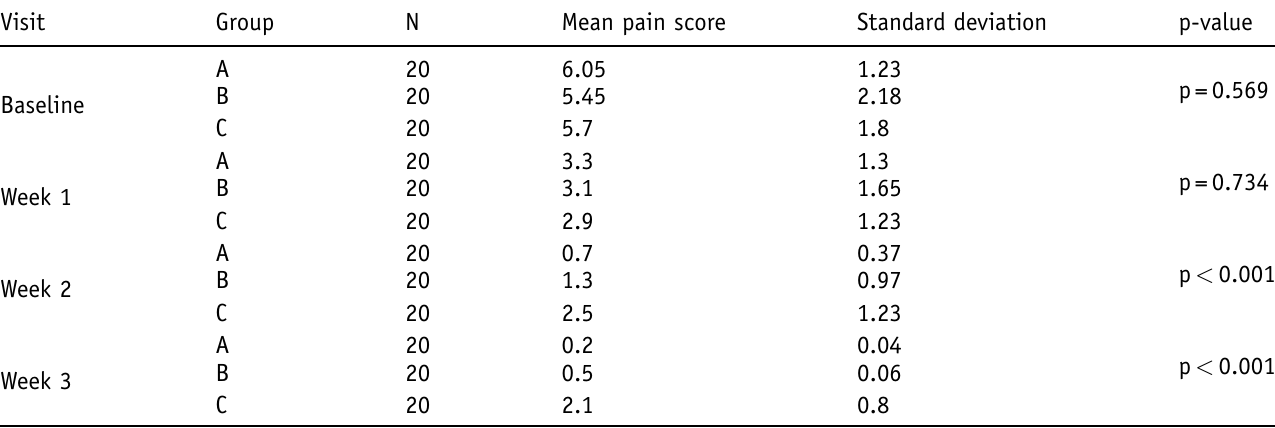
Table I. Comparison of mean pain scores between the three groups.